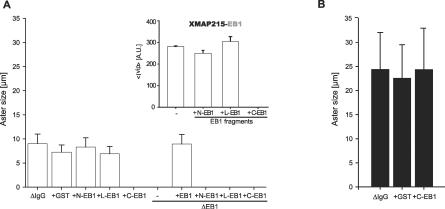
C-EB1 Inhibits XMAP215-EB1 Interaction and Destabilizes MTs in Metaphase Xenopus Egg Extracts(A) Effect of EB1 fragments on aster size (±S.D., n > 30) in undepleted and ΔEB1 metaphase extracts. VIP experiment of XMAP215/EB1-EGFP interaction in metaphase extract in response to addition of buffer (control), N-terminal domain (N-EB1), linker domain (L-EB1), or C-terminal domain (C-EB1) of EB1 (inset). Error bars represent the s.e.m. of <Ivip> measured in three different microscopic fields.(B) Effect of C-EB1 on aster size in interphase (± S.D., n > 30)